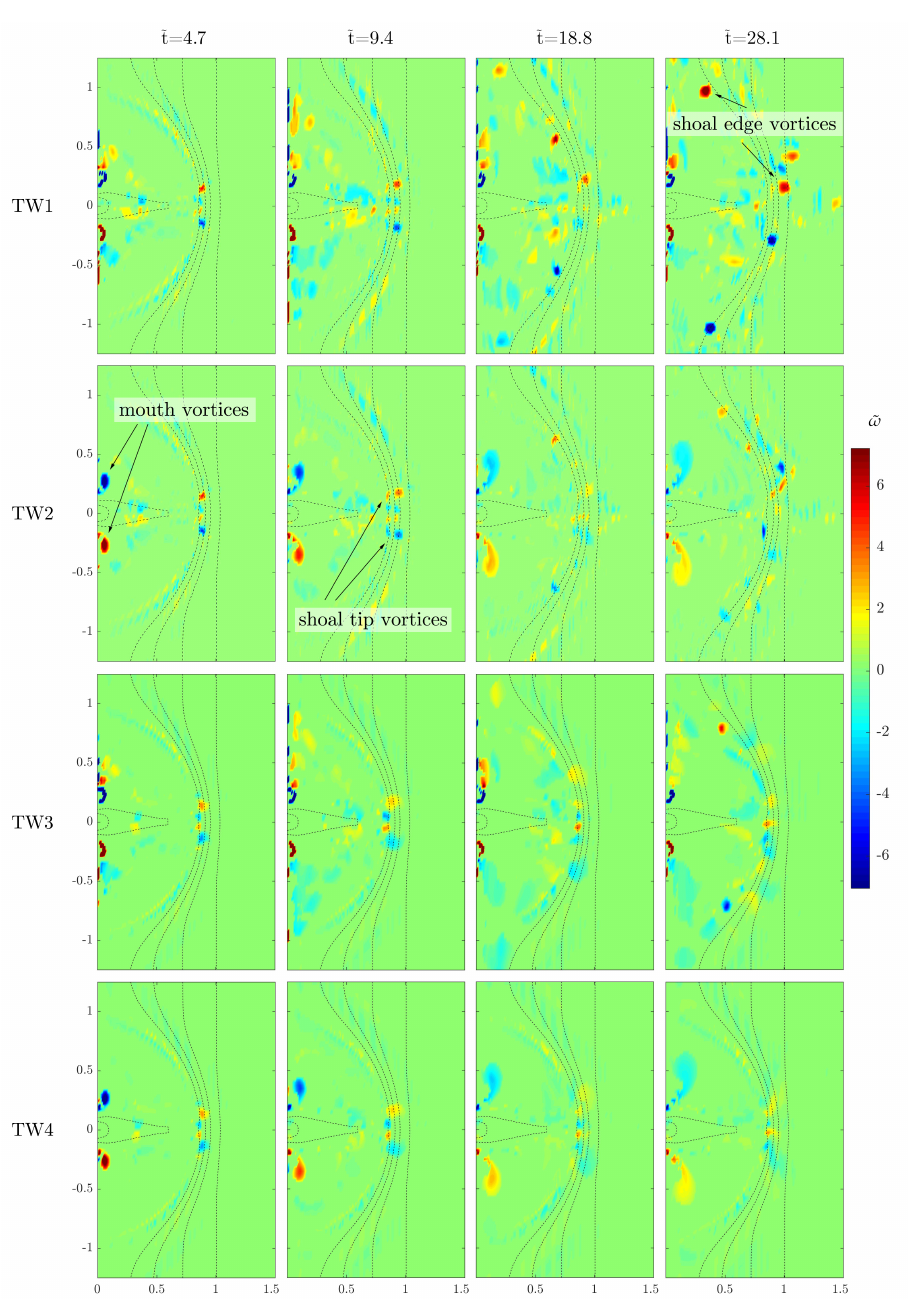
Figure 9. Time evolution of vorticity for the four tests with a monochromatic wave opposing the river current. Each row represents a single test (from top to bottom: TW1 to TW4). Each column represents a single time level (from left to right: ˜ t = 4.7, 9.4, 18.8, and 28.1). Red tones represent clockwise vorticity; blue tones represent anticlockwise vorticity. The dotted lines show the bathymetry contours of the shoal edge and the main